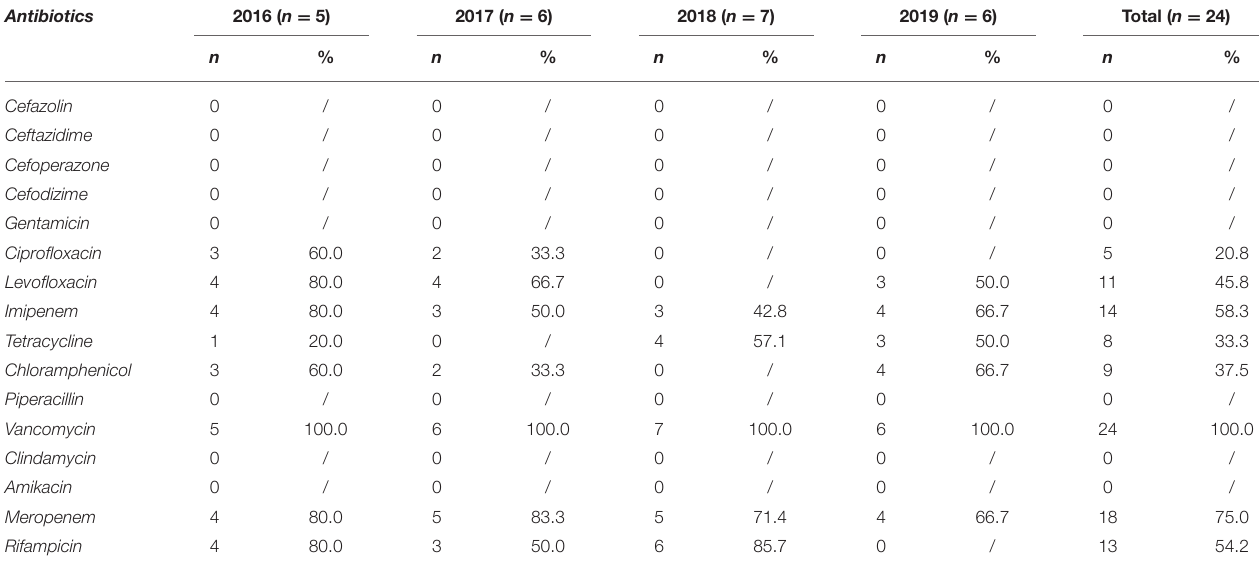
TABLE 3 | Susceptibility of Staphylococcus pathogens to antibiotics. Antibiotics